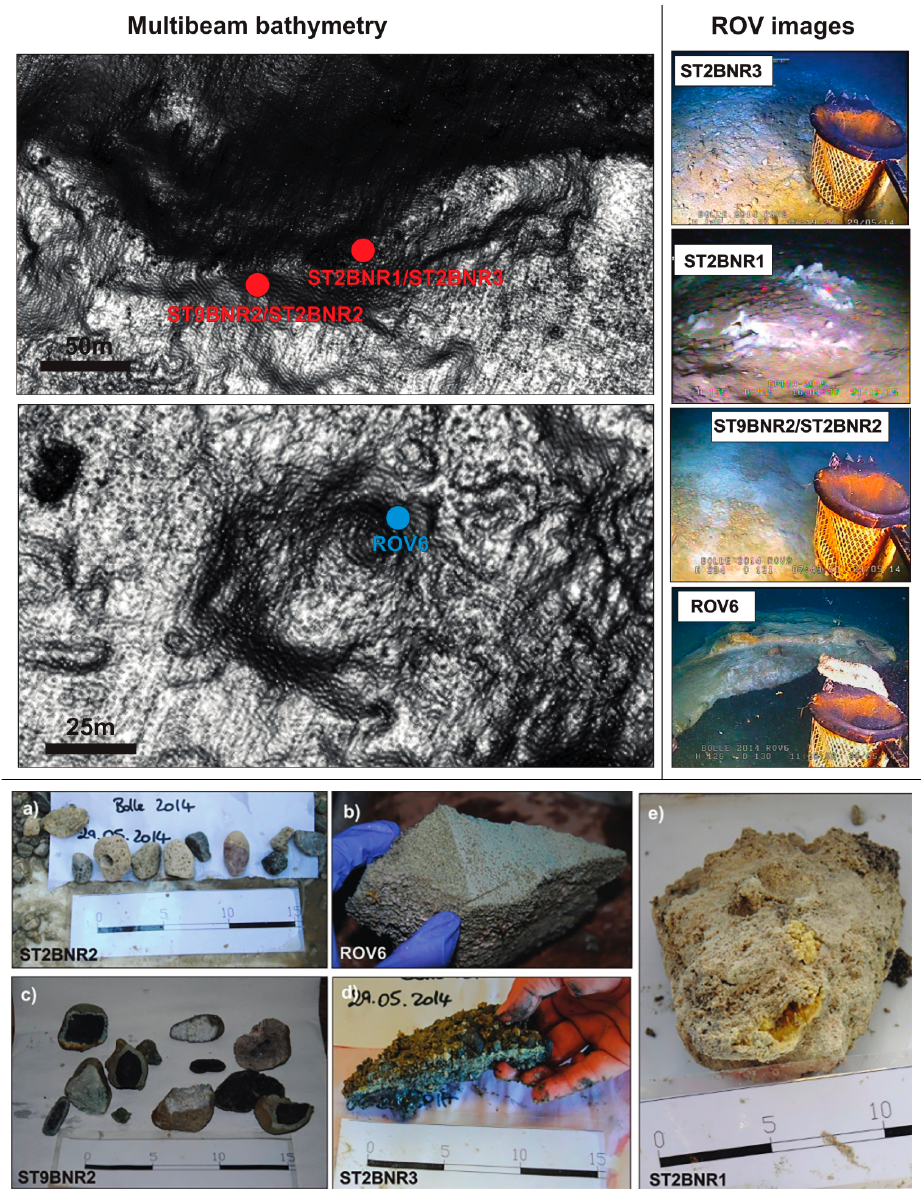
Figure 2. Multibeam bathymetry, ROV images of the sampled sites and images of the clasts ( a , c ) and crusts ( b , d , e ) analyzed in this study. crusts ( b , d , e ) analyzed in this